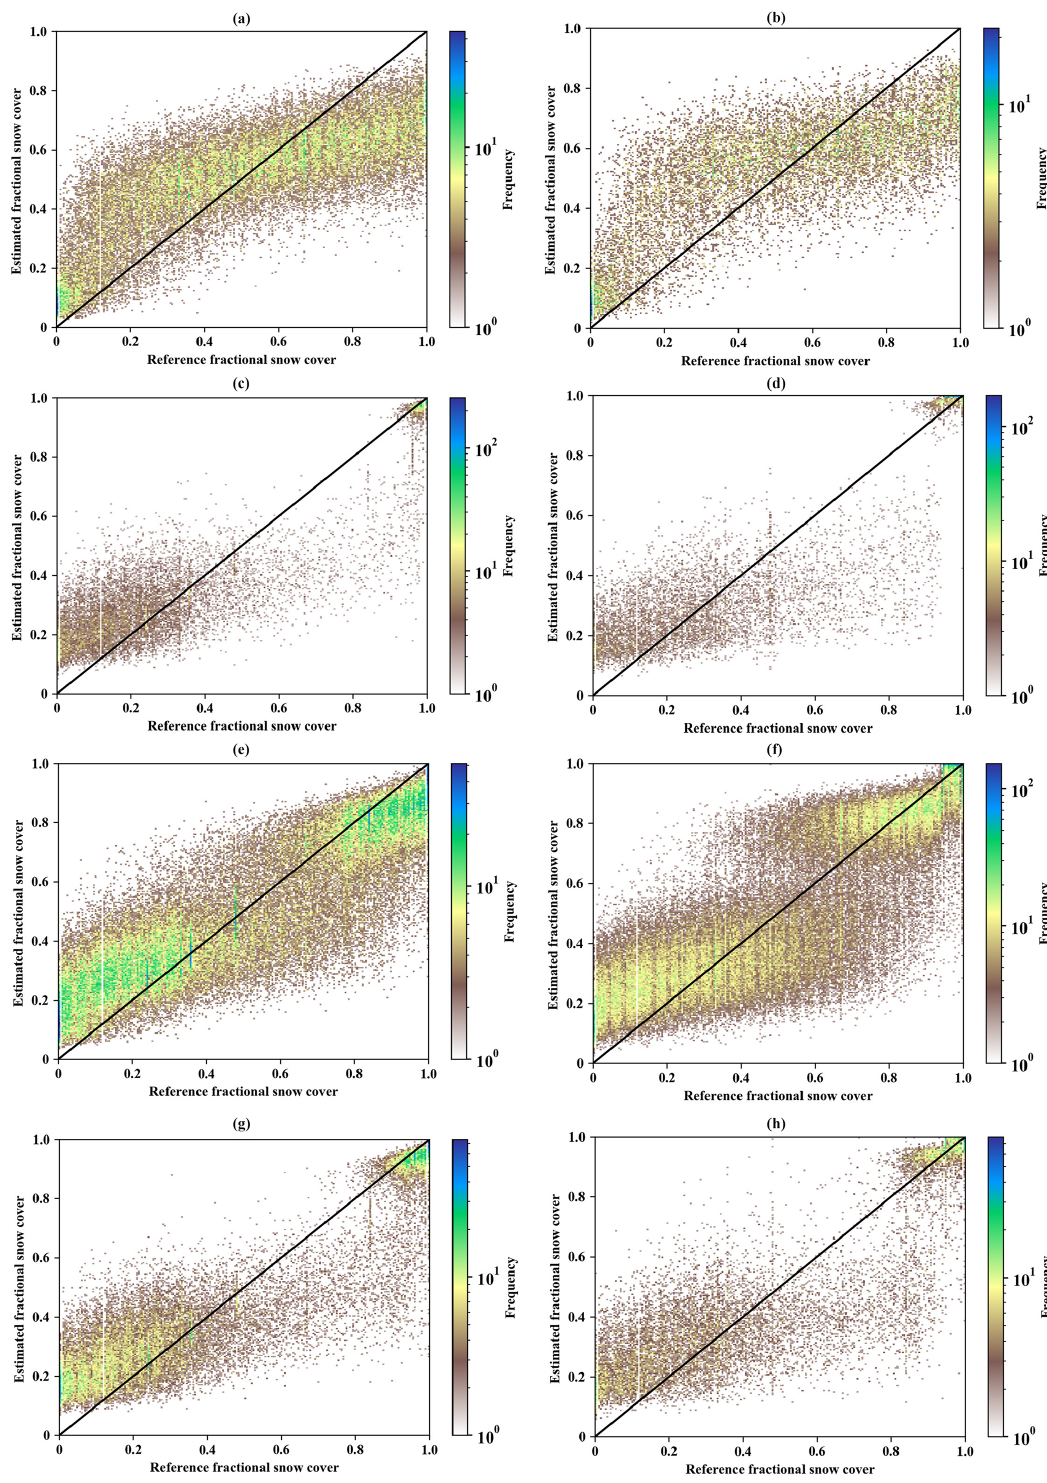
Figure 7. The color density scatter plots between the estimated fractional snow cover and MODIS-derived fractional snow cover in January and February for four land cover types (forest: a , b ; shrub: c , d ; prairie: e, f ; bare land: g, h ). The left column is the results of the training stage (a, c, e, g) ; the right column is the results of the evaluation stage (b, d, f, h) . Statistics metrics refer to Table 6: Training and Evaluation 1. Note that 0.3% of the independent evaluation dataset in January and February of 2008, 2009, and 2017 was randomly selected as the evaluation sample with stratified random